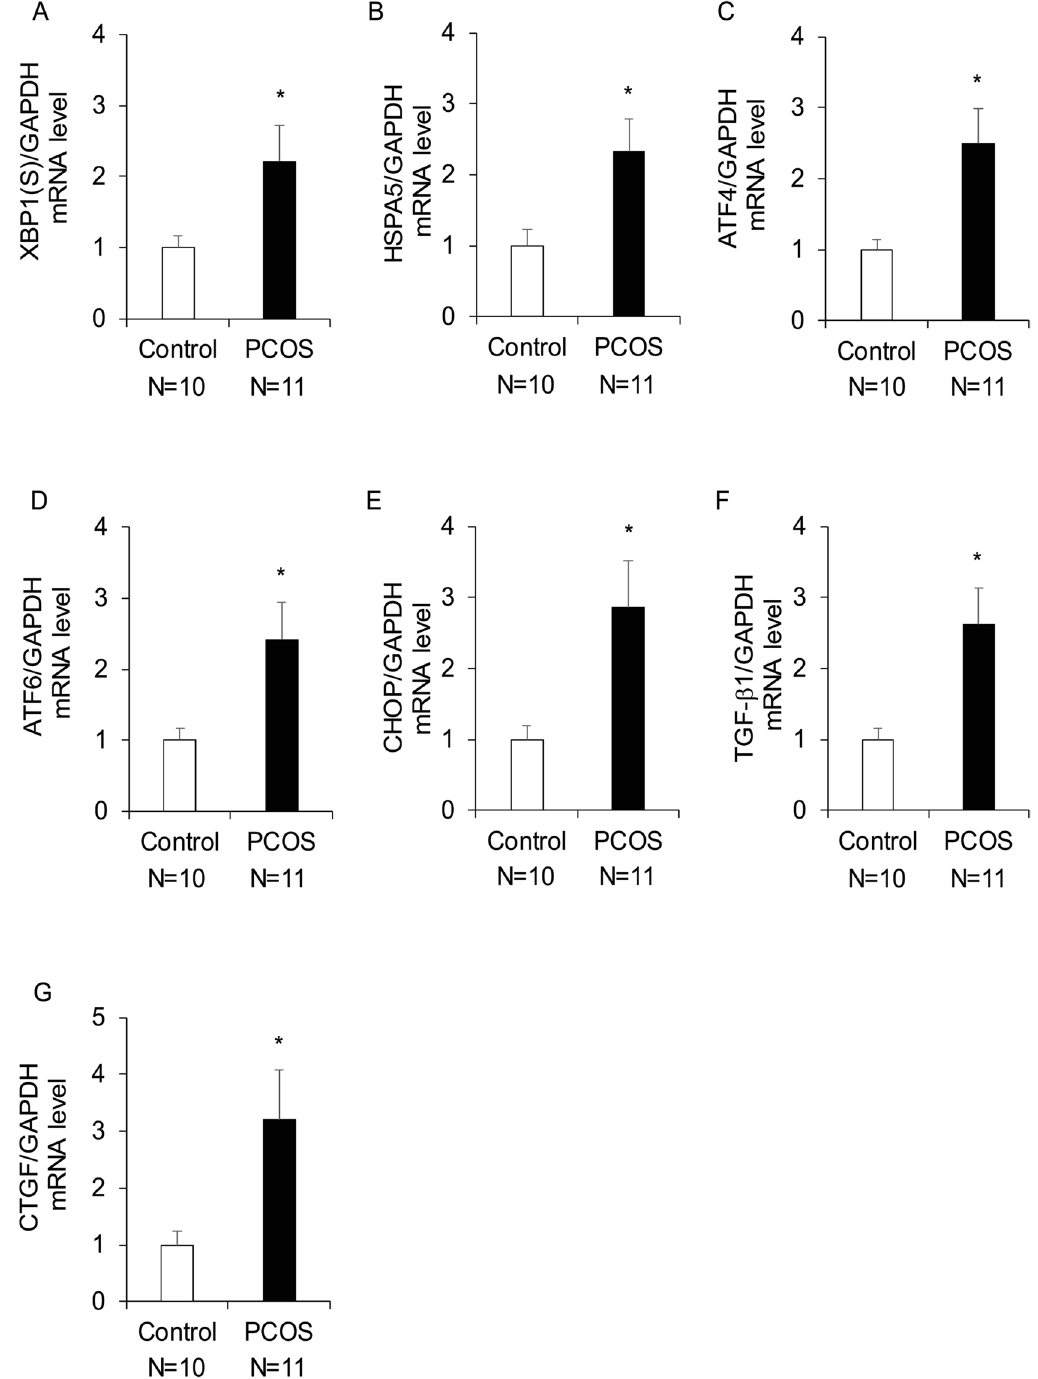
Figure 1. The expression of UPR genes and pro-fibrotic growth factors in granulosa-lutein cells from control (n = 10) and PCOS (n = 11) patients. The expression levels of ( A – E ) UPR genes, XBP1(S), HSPA5, ATF4, ATF6, and CHOP mRNA and ( F , G ) pro-fibrotic growth factors, TGF- β 1 and CTGF mRNA in granulosa-lutein cells were measured by real-time PCR and normalized to that of GAPDH. Increased UPR gene expression was indicative of ER stress activation. The values represent means ± SEM. * p <